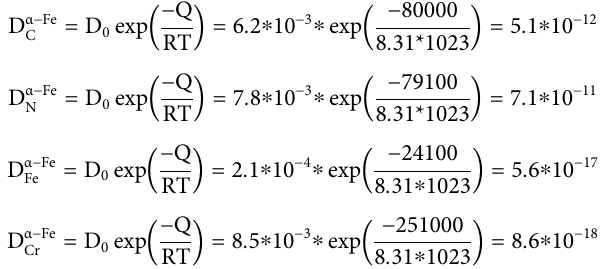
Frontiers in Materials |